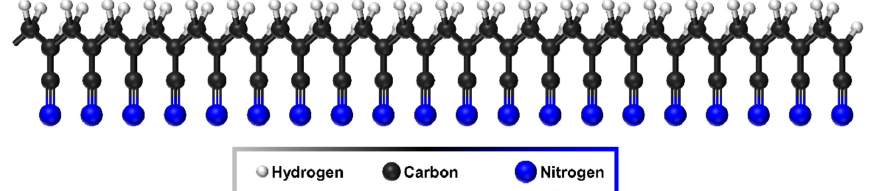
Figure 2. Schematic illustration of PAN molecular structure.